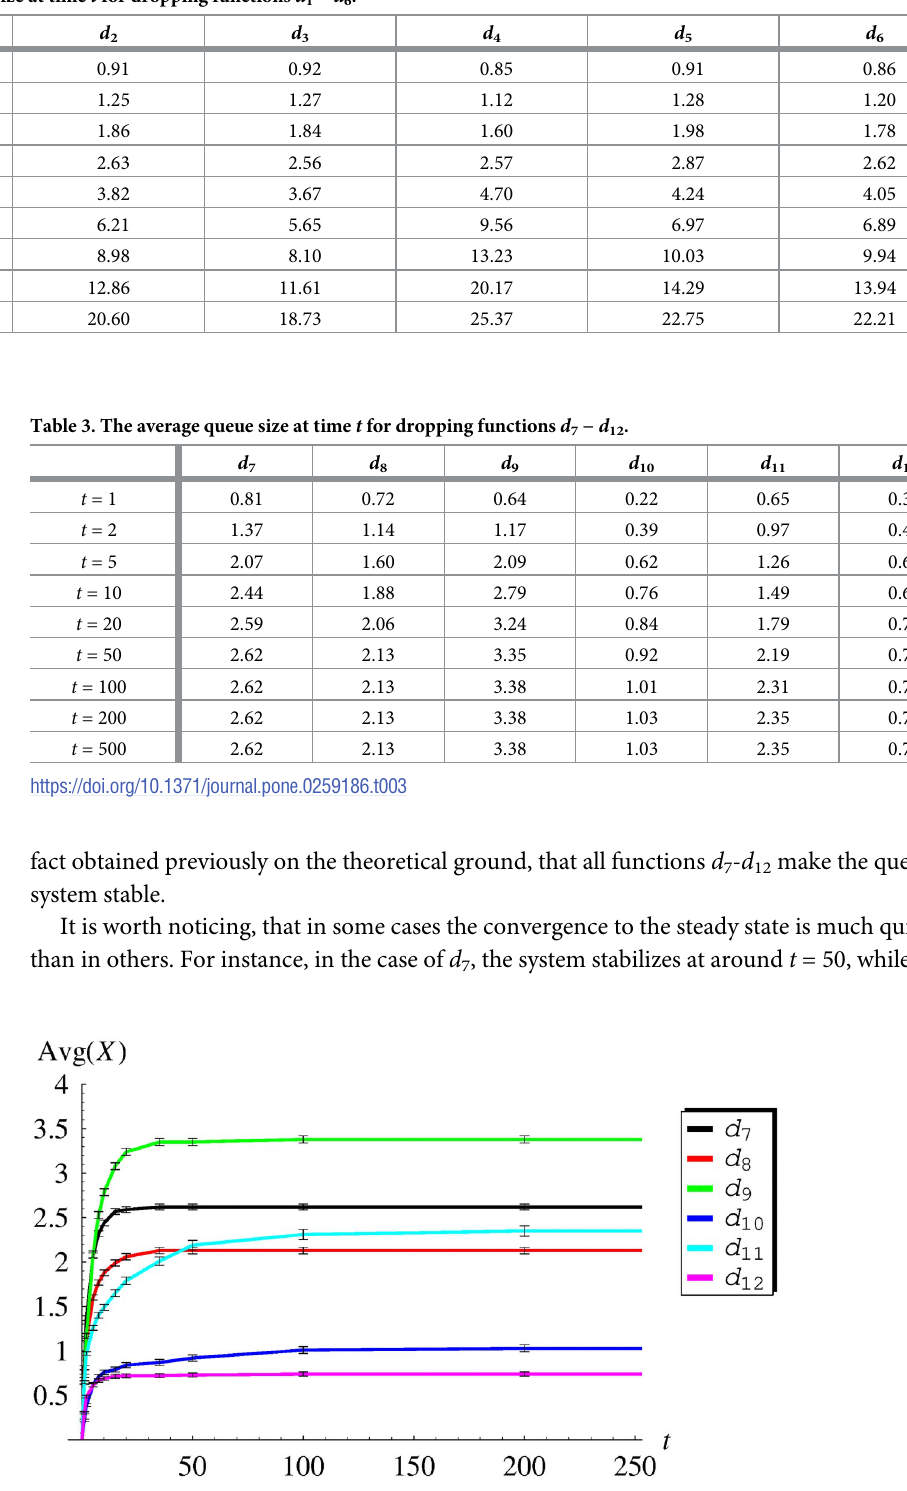
Fig 3. The average queue size versus time for dropping functions d 7 − d 12 . The confidence intervals for the confidence level of 0.99 are added.